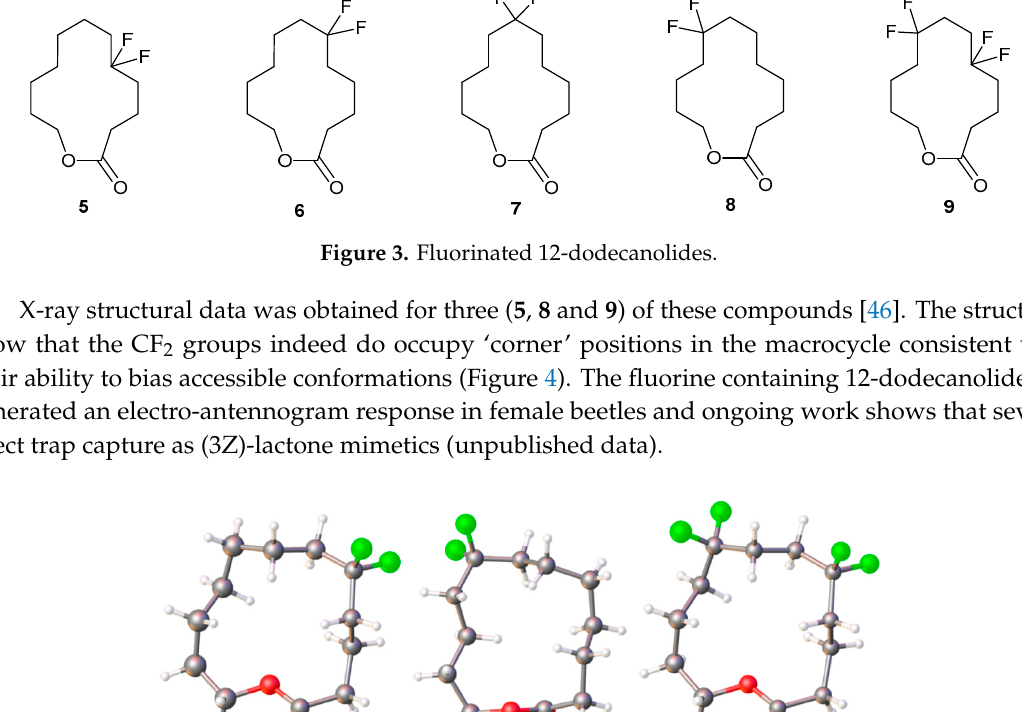
Figure 4. Representations of the X-ray derived structure of 12-dodecanolides 5 , 8 and 9 (left to right). In all cases the CF 2 groups adopt corner locations in the solid state.